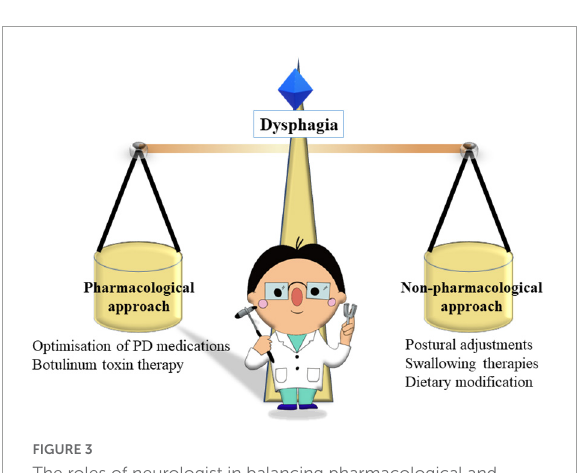
FIGURE3 The roles of neurologist in balancing pharmacological and non-pharmacological approaches in